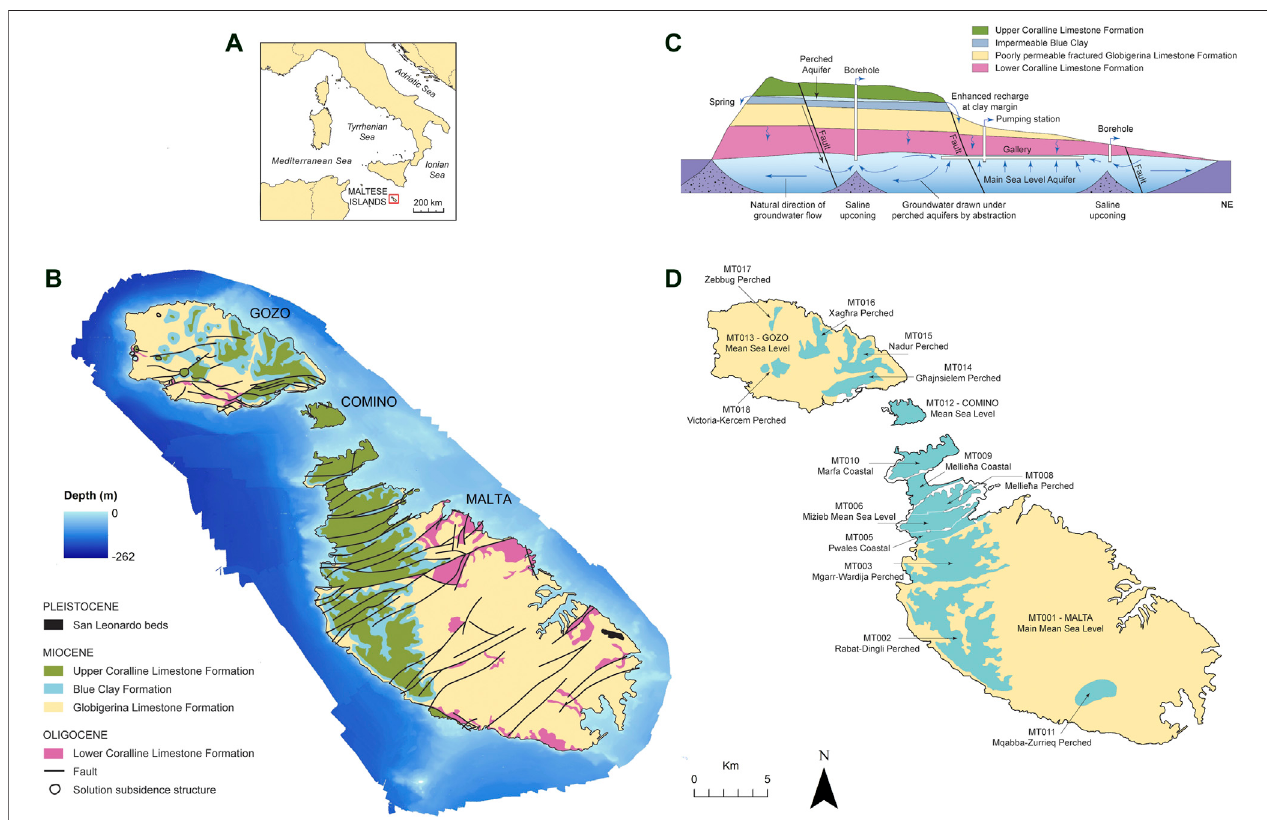
FIGURE4| Thelocation (A) ,geology,faulting,andbathymetry (B) ,andaquiferstructure (C,D) oftheMalteseIslands(GeologicalmapredrawnfromOilExploration Directorate, 1993; Bathymetric map from ERDF LIDAR data, 2012; aquifer data from Malta Resource Authority, 1994).